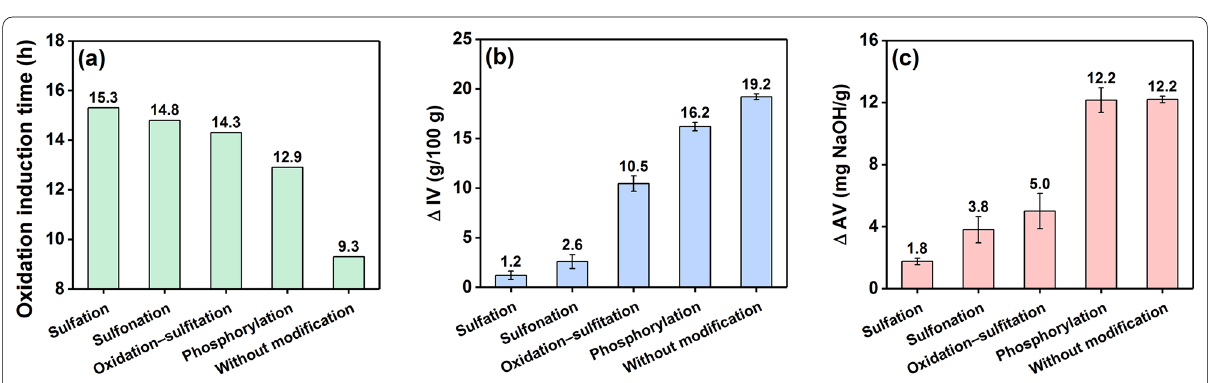
Fig. 6 Effect of modification of rape oil on its oxidation induction time ( a ), ∆ IV ( b ), and ∆ AV ( c